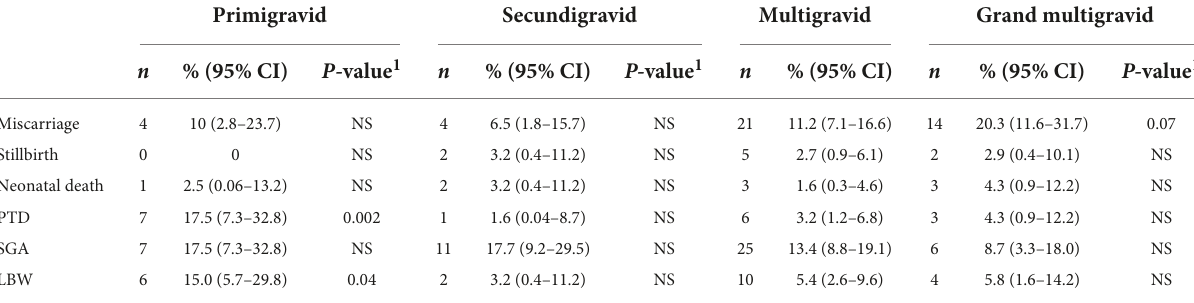
TABLE 3B Adverse outcomes in the study population stratified by gravidity. Primigravid Secundigravid Multigravid